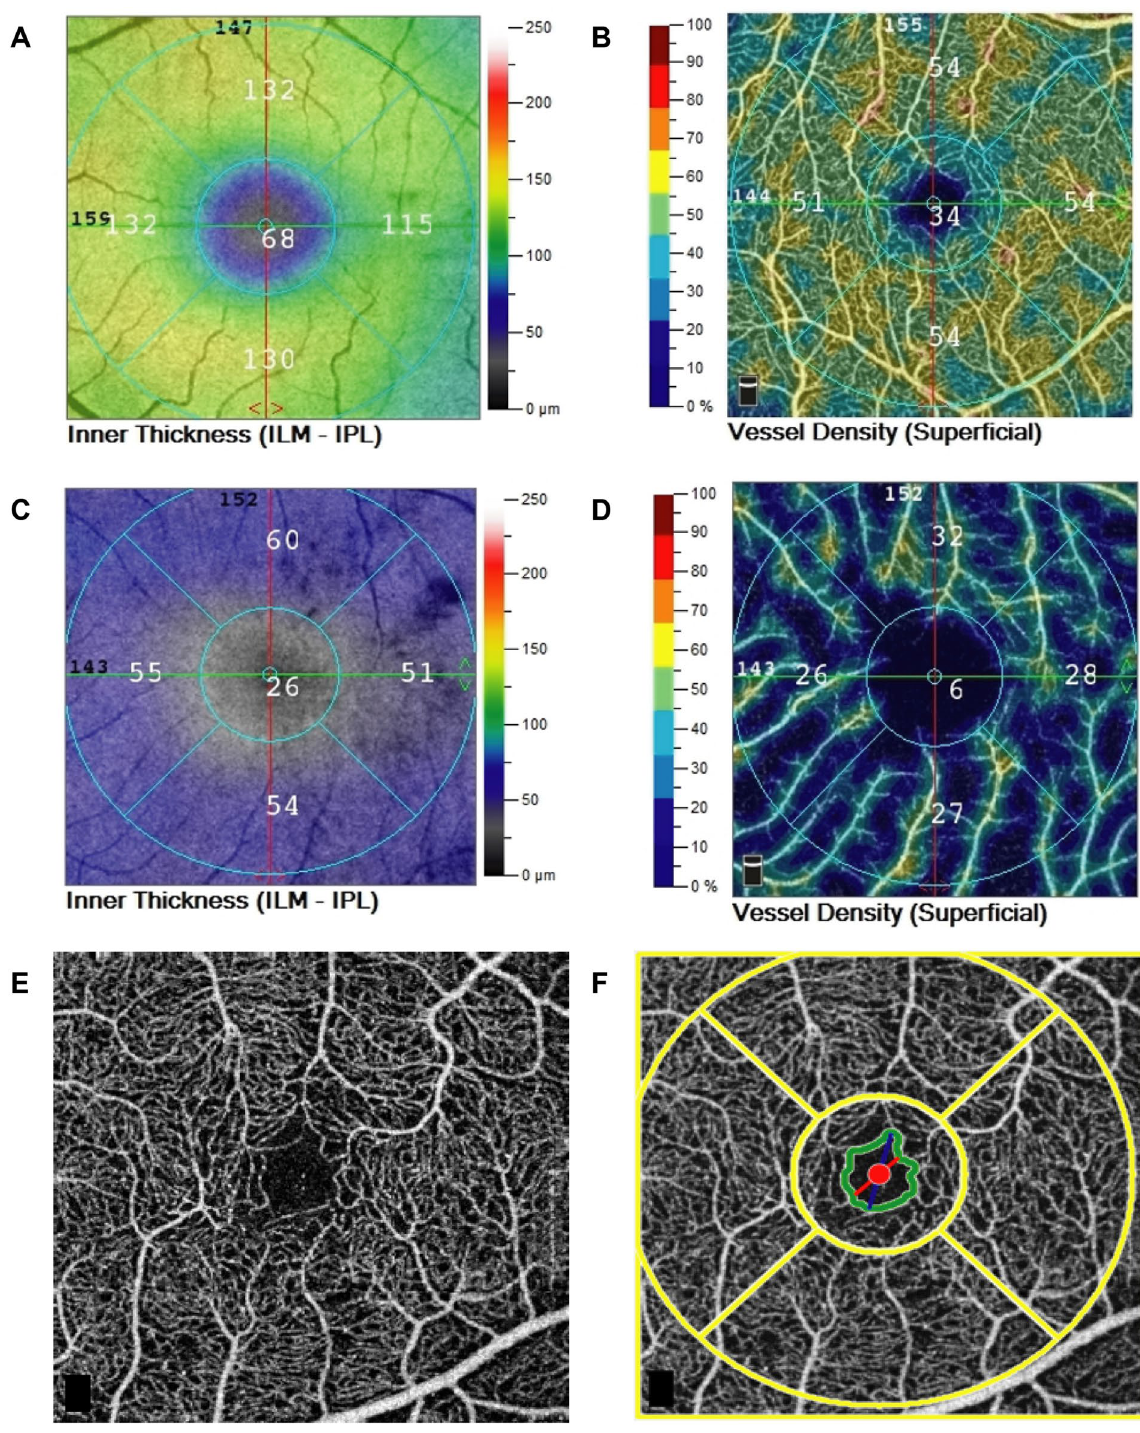
Figure 1. Example of OCT and OCTA images obtained from a healthy ( A , B ) and glaucomatous patient ( C , D ) showing inner macular thickness (IMT) ( A , C ) and superficial pfVD ( B , D ). En face macular OCTA images are shown ( E , F ), with ( F ) showing an OCTA image with the foveal avascular zone (FAZ) outlined (green fovea (Fig. 1) 27 . The quality of OCTA scans was assessed and those with quality scores (calculated automatically by the device software) of ≤ 4, motion artefact, decentration or poor clarity were repeated. If the repeat scan was also of poor quality the eye was excluded from the analysis. Superficial capillary plexus OCTA images were also analyzed with VAMPIRE (Universities of Edinburgh and Dundee, UK) 23 . Retinal vessels were segmented by denoting each pixel as vessel or non-vessel to produce segmented images 28 . Resulting images were skeletonized using interactive deletion of pixels using MATLAB’s